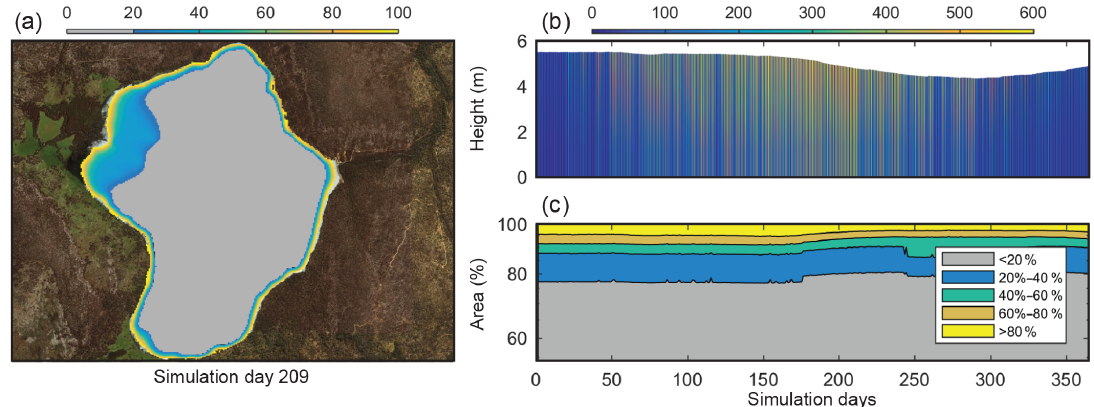
< 0 . 2 (i.e. less than 20% of surface crit